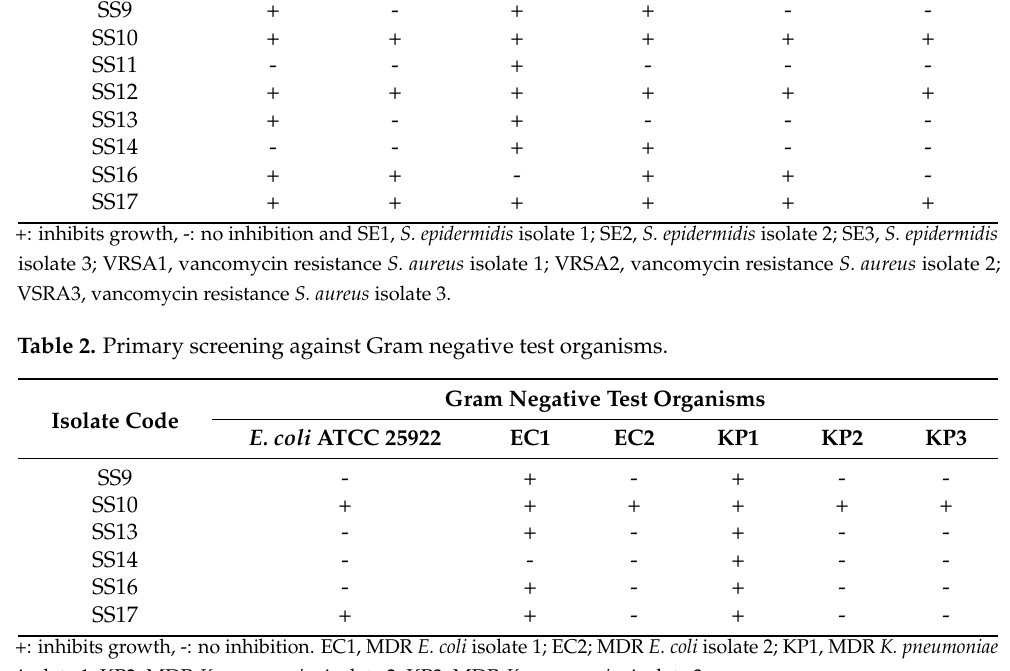
Table 3 revealed the results of the antimicrobial activity (measured in zone of inhi-